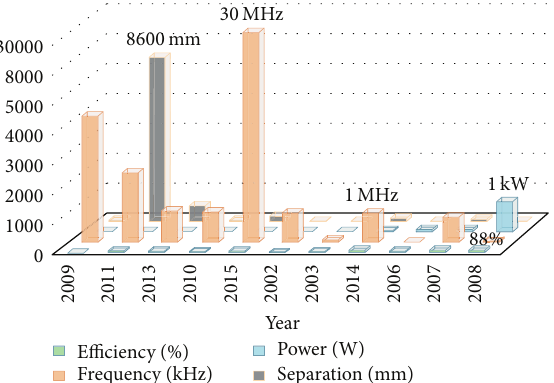
Figure 4: Overall summary of the AET evaluation (values are taken from lower to higher power